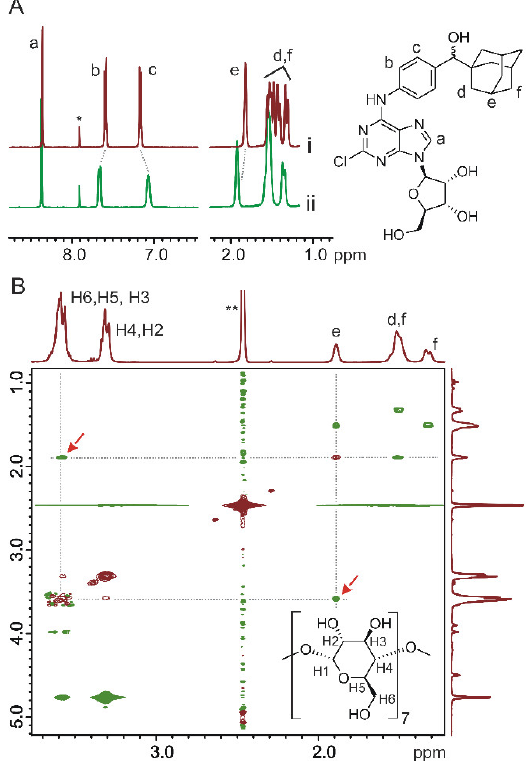
Figure 5. ( A ) Portions of the 1 H-NMR spectra of the single compound 24 (i) and after the addition of 1 equiv. of β-CD (ii). ( B ) A ROESY spectrum of the latter mixture. All spectra were recorded in a mixture of DMSO- d 6 /D 2 O, 2/1, v / v at 303 K at 400 MHz. Signals of residual CHCl 3 and DMSO- d 5 are labelled with * and **, respectively.